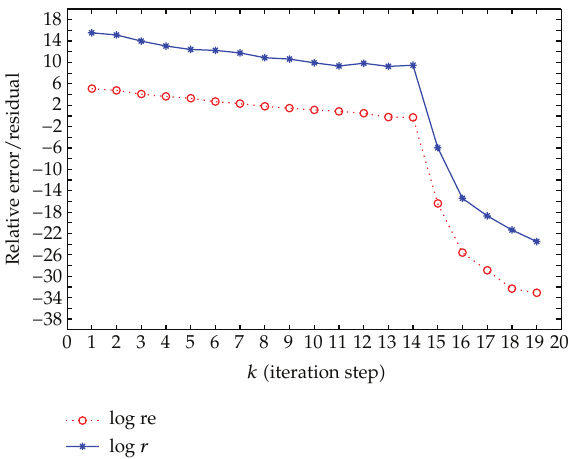
Figure 3: The relative error of the solution and the residual for Example